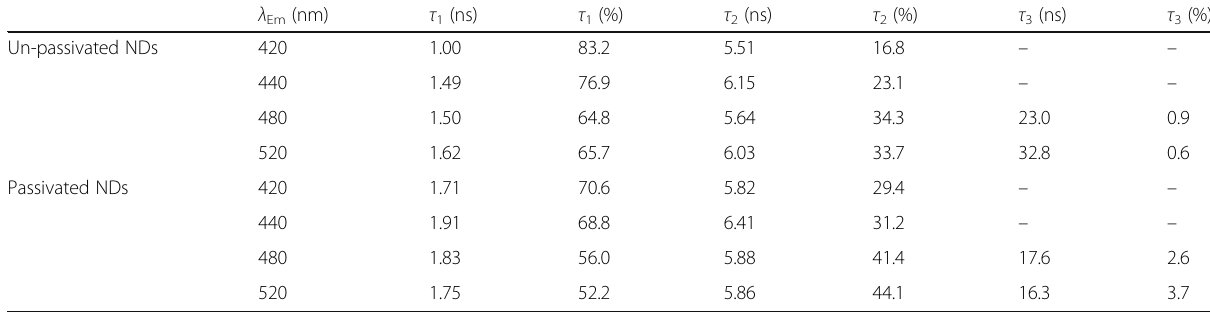
Table 1 Lifetimes ( τ 1 , τ 2 , and τ 3 ) and relative contributions for un-passivated and passivated NDs at 390 nm excitation